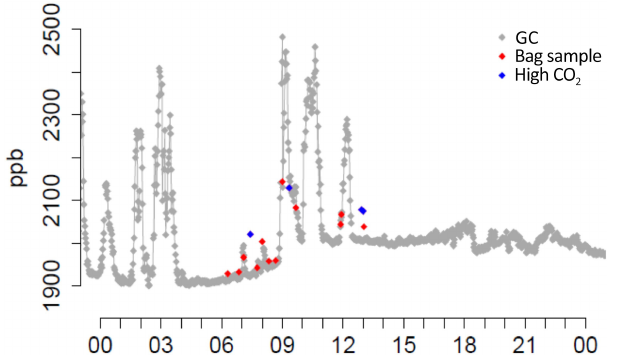
Figure 2. Methane mixing ratios measured by the GC-FID in Had- denham church on 11 February 2015 are presented in grey. Match- ing methane mixing ratios collected in Tedlar bags on 11 Febru- ary 21015 and analysed on the 20 February 2015 using a Picarro CRDS at Royal Holloway, University of London, are presented as red points.